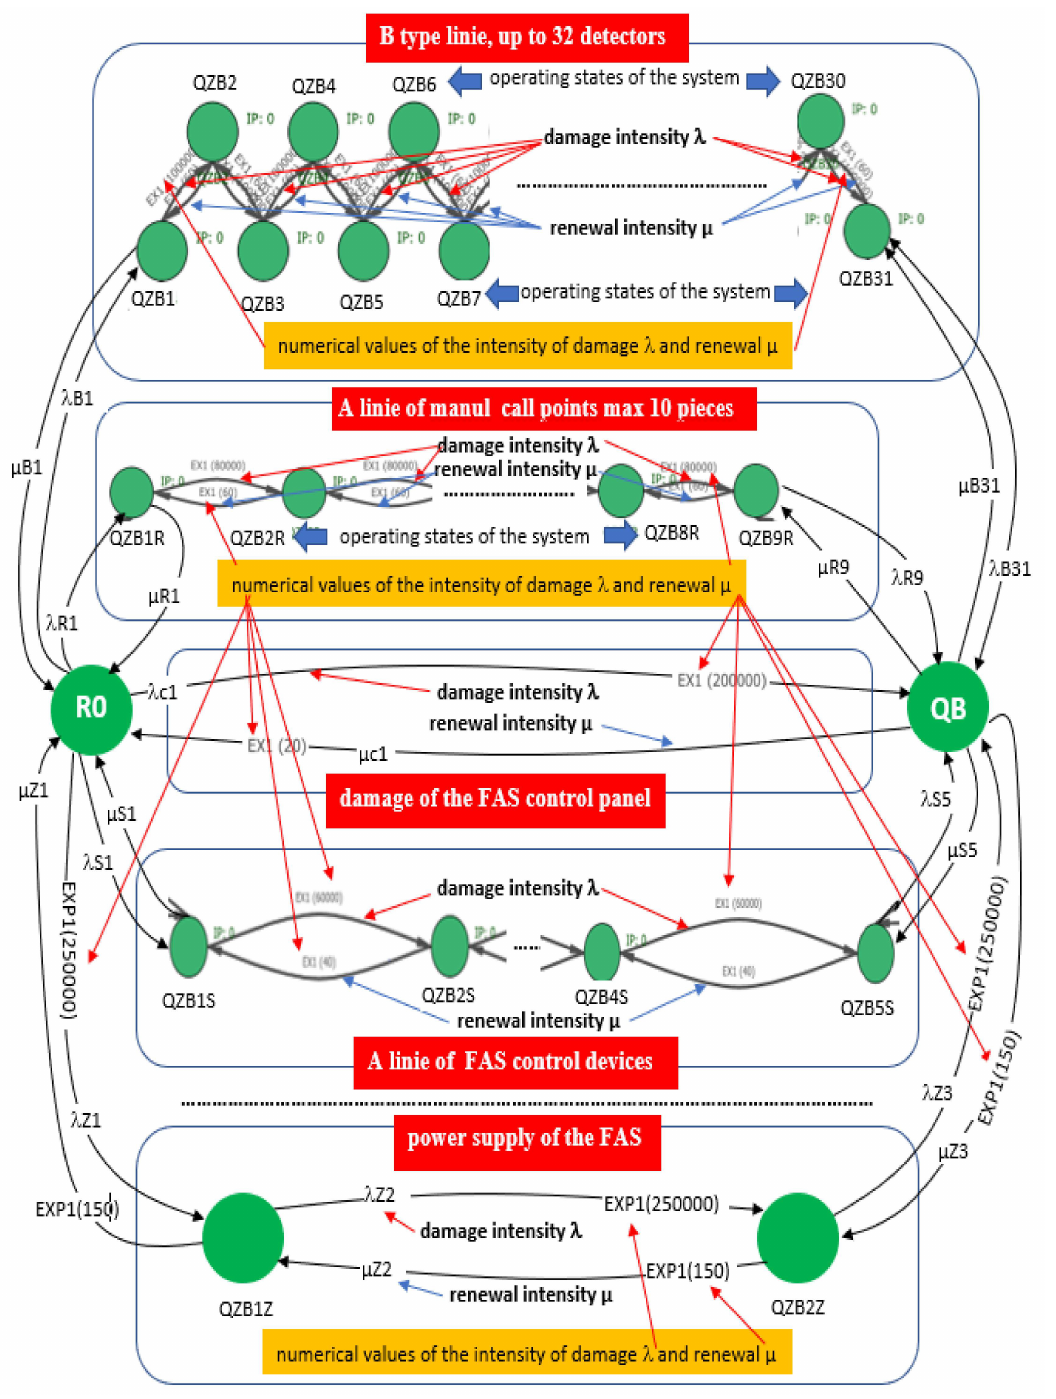
Figure 15. Migration of possible states for a focused FAS with B-type open lines for detectors, MCPs and control modules, without sending alarm and damage signals to the State Fire Service (graph printout from the BlockSim